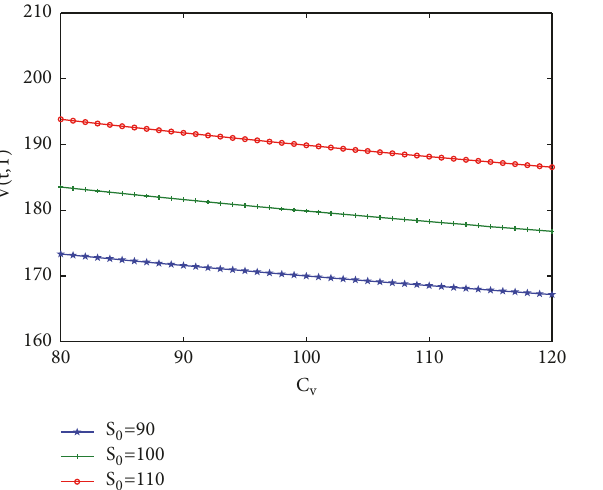
Figure 4: The warrant bond price with different 𝑏 .